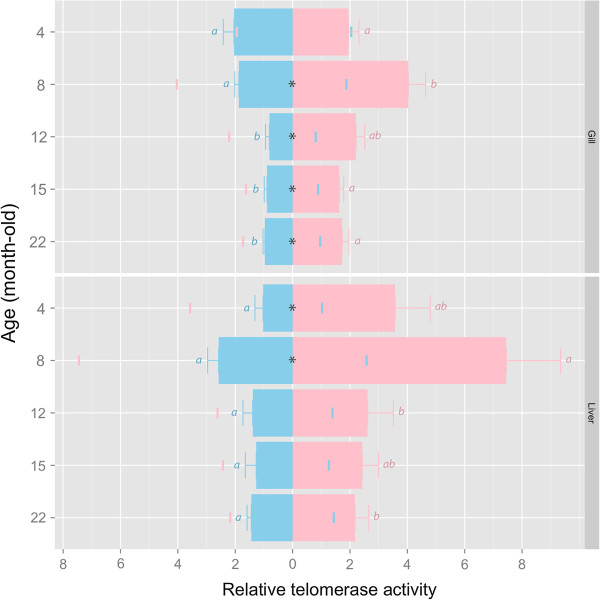
Change of telomerase activity in male (blue) and female (pink) O. latipes during aging (upper: gill; lower: liver). Relative telomerase activity is denoted by the bar length and the colored mark on the opposite side of the origin. Error bars are standard error of mean (SEM). Bars annotated with different alphabets are significantly different. Asterisk (*) indicates significant sex difference at that particular age (FDR-adjusted p < 0.05).